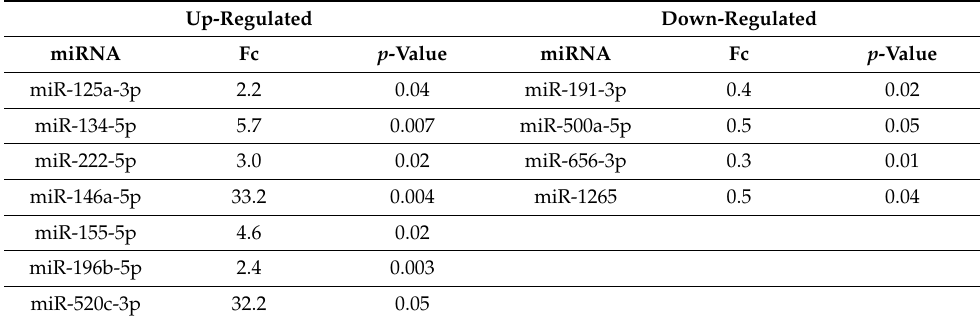
Table 1. Up- or down-regulated miRNAs by the IL-1 β treatment. Fc= fold change. Up-Regulated Down-Regulated miRNA Fc p -Value miRNA Fc p